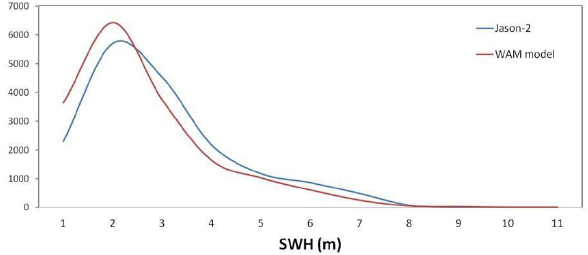
Fig. 4. Distribution of the satellite measurements and the model data in various bins. The bins follow the pattern 0–0.5, 0.5–1.0, 1.0–1.5,